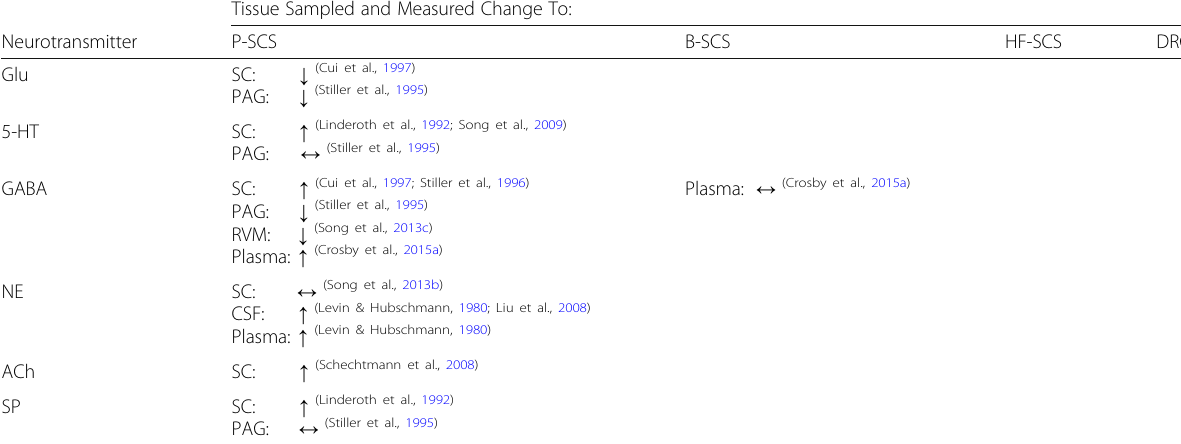
Table 1 Measured Neurotransmitters in response to spinal cord stimulation (SCS) Tissue Sampled and Measured Change